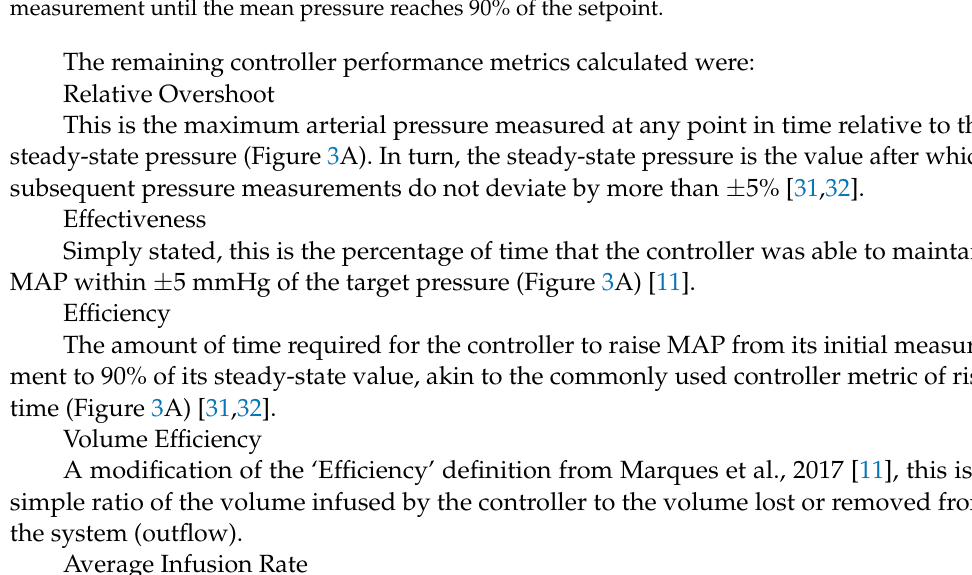
Figure 3. Graphical representation of controller performance metrics assessed with HATRC. ( A ) Representative mean pressure vs. time plot showing overshoot (maximum deviation from the pressure at steady state), effectiveness (boundary for the time spent within ± 5 mmHg from the pressure setpoint), performance error (percent difference between MAP and setpoint), and efficiency (time required for MAP to reach 90% of the steady-state value). ( B ) Divergence is calculated as the slope of the linear regression of the absolute performance error against time. ( C ) Representative mean pressure vs. time plot showing area above setpoint pressure, area below setpoint pressure, and area rise time. Each is defined as the total area enclosed by the mean pressure curve and the setpoint line either above or below setpoint, with the area rise time limited to the region from the first measurement until the mean pressure reaches 90% of the